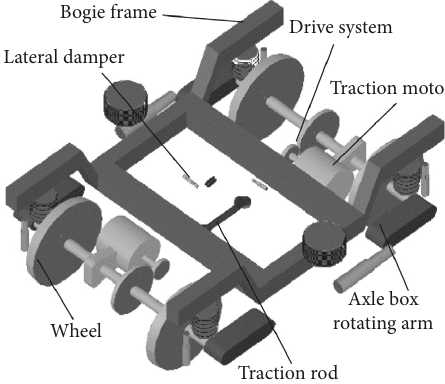
Figure 1: Railway vehicle bogie model.